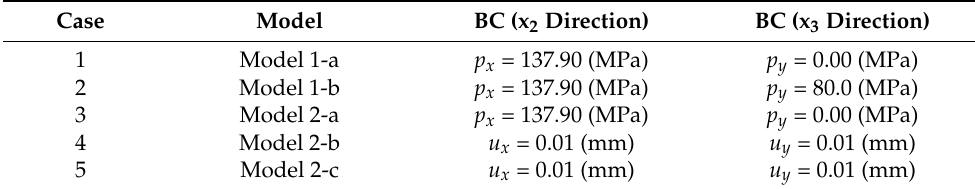
Table 7. Description of finite element models and associated boundary conditions